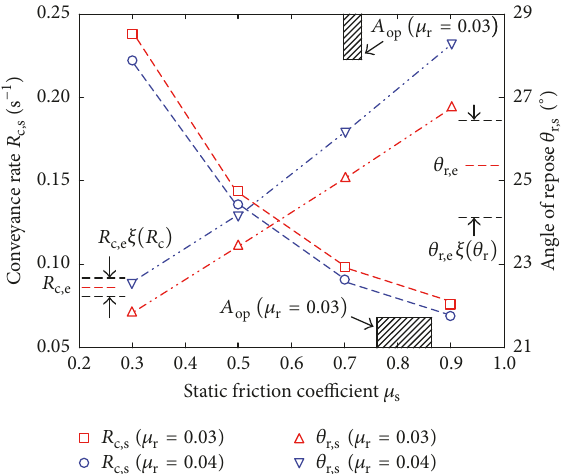
Figure 11: Particle directional conveyance in the trough ( 𝑌 h = 0.4, 𝑌 𝑌 a = 0.2, and b =